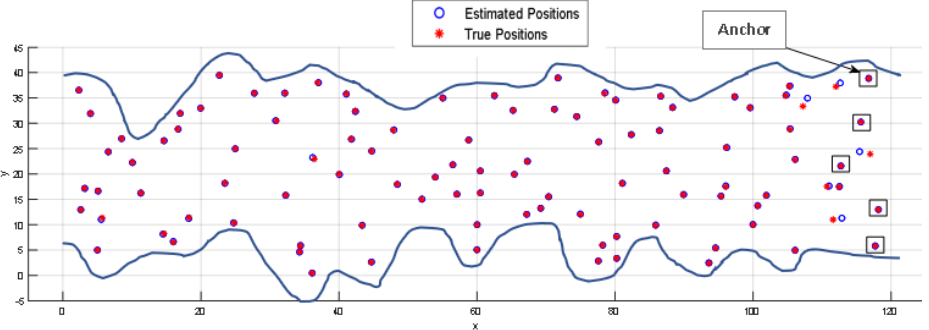
Figure 7. The true and estimated sensor positions at R = 30 and σ 2 = 10 dB, second configuration,